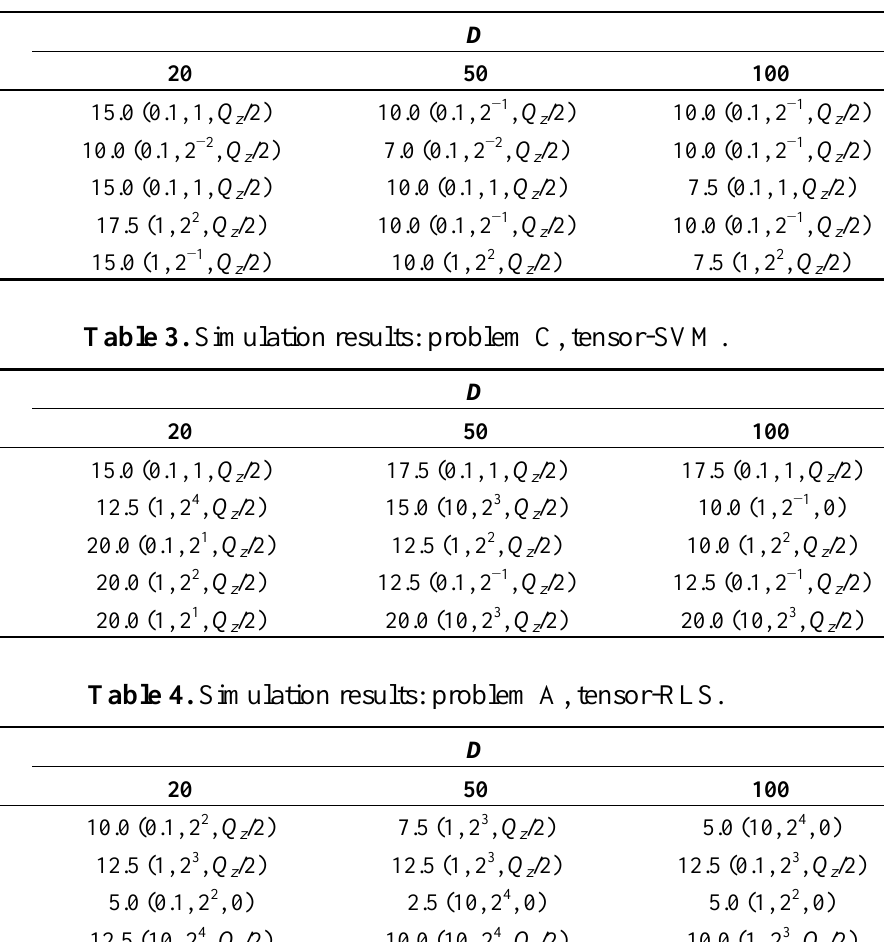
Table 2. Simulation results: problem B, tensor-SVM.